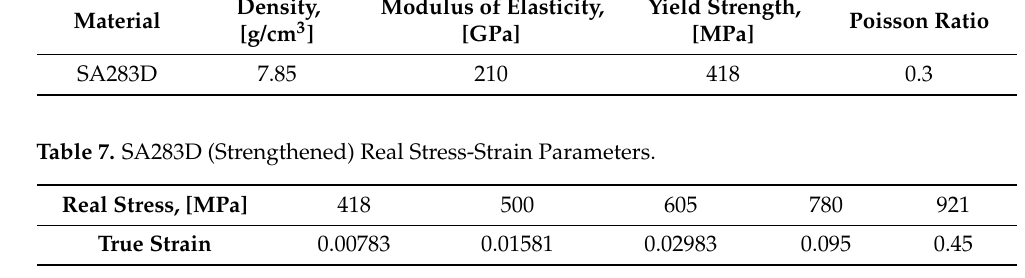
Table 6. Mechanical properties parameters of SA283D (Strengthened).